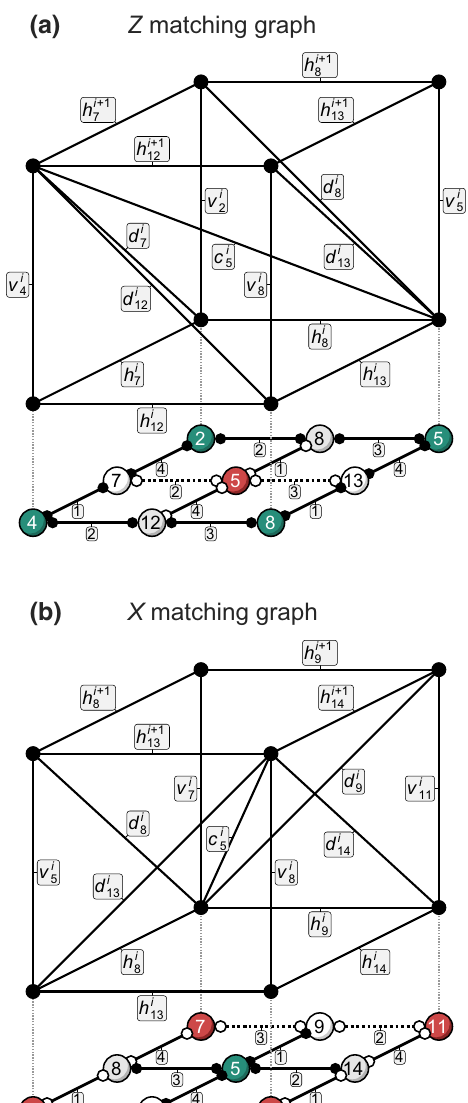
FIG. 7. Sections of the Z (a) and X (b) matching graphs, here with labels corresponding to the code distance d = 5 similarly to Fig. 4. Each two-mode gate is labeled with a number correspond- ing to the step in the i th round of syndrome